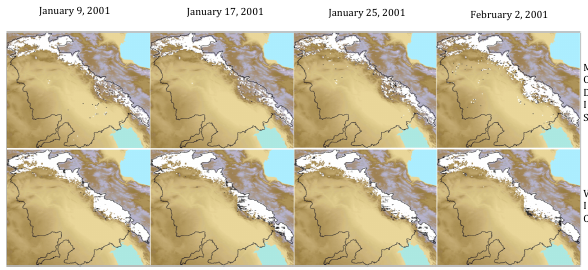
Figure 6 . Comparison of observed (top) and simulated (bottom) snow covered areas in the Euphrates-Tigris basin across different periods in winter 2001. Snow cover is indicated in white against the color-coded topography of the basin. Fig. 6. Comparison of observed (top) and simulated (bottom) snow Observations in the top row were extracted from Terra MODIS 8-day snow cover product (MOD10C2) at 0.05 degree covered areas in the Euphrates-Tigris basin across different periods spatial resolution, while the simulated results of the bottom row were produced in this research using the VIC model. in winter 2001. Snow cover is indicated in white against the color- More details on the MODIS snow cover product can be found in Hall et al (2002). Each date at the top indicate the coded topography of the basin. Observations in the top row were ex- 45 beginning date of the 8-day compositing period. tracted from Terra MODIS 8-day snow cover product (MOD10C2) at 0.05 ◦ spatial resolution, while the simulated results of the bot- tom row were produced in this research using the VIC model. More details on the MODIS snow cover product can be found in Hall et al. (2002). Each date at the top indicate the beginning date of the 8-day compositing